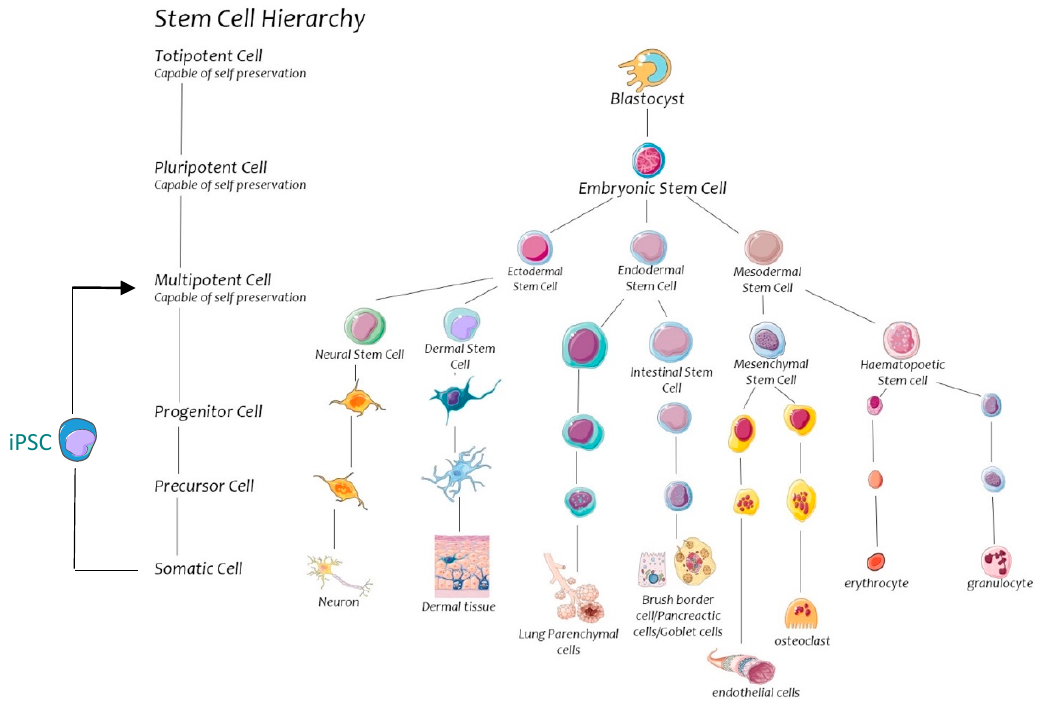
Figure 1. Totipotent cells of the blastocyst are capable of differentiation into embryonic and placental tissue. Stem cells can be grouped into three primary dermal layers (endodermal, ectodermal and mesodermal) and eventually mature into various somatic cells. Induced pluripotent stem cells (iPSC) are formed when somatic cells are manipulated to regress their maturity.